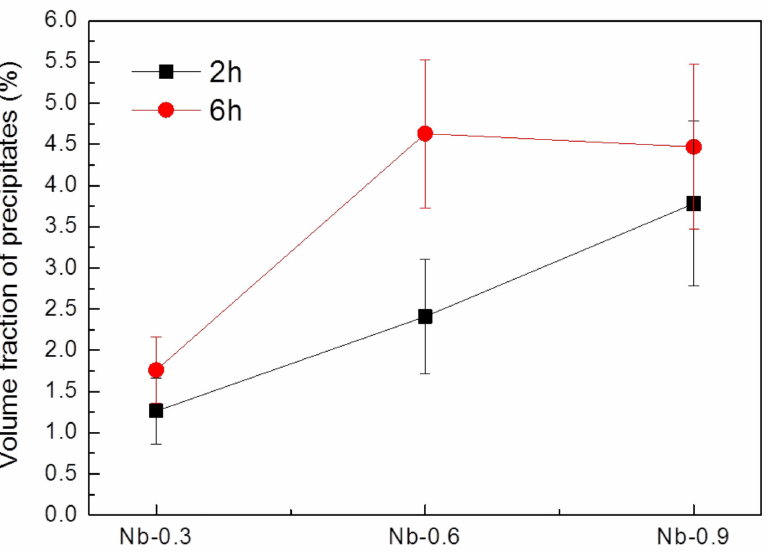
Figure 7. Volume fraction of precipitates in the 22Cr25NiWCuCo(Nb) steel specimens with different Nb contents after heat treatment at 1200 ◦ C for 2 and 6 h.